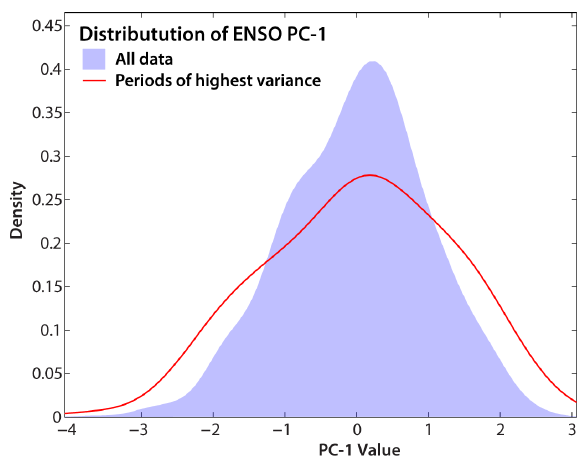
Fig. 7. Distribution of the annual PC-1 scores from Li et al. (2011) using all data (blue shading) and during windows of increased vari- ance ( ≥ 1 . 5, Fig. 3d). The distribution is wider during periods of increased variance but does not have a tail favoring La